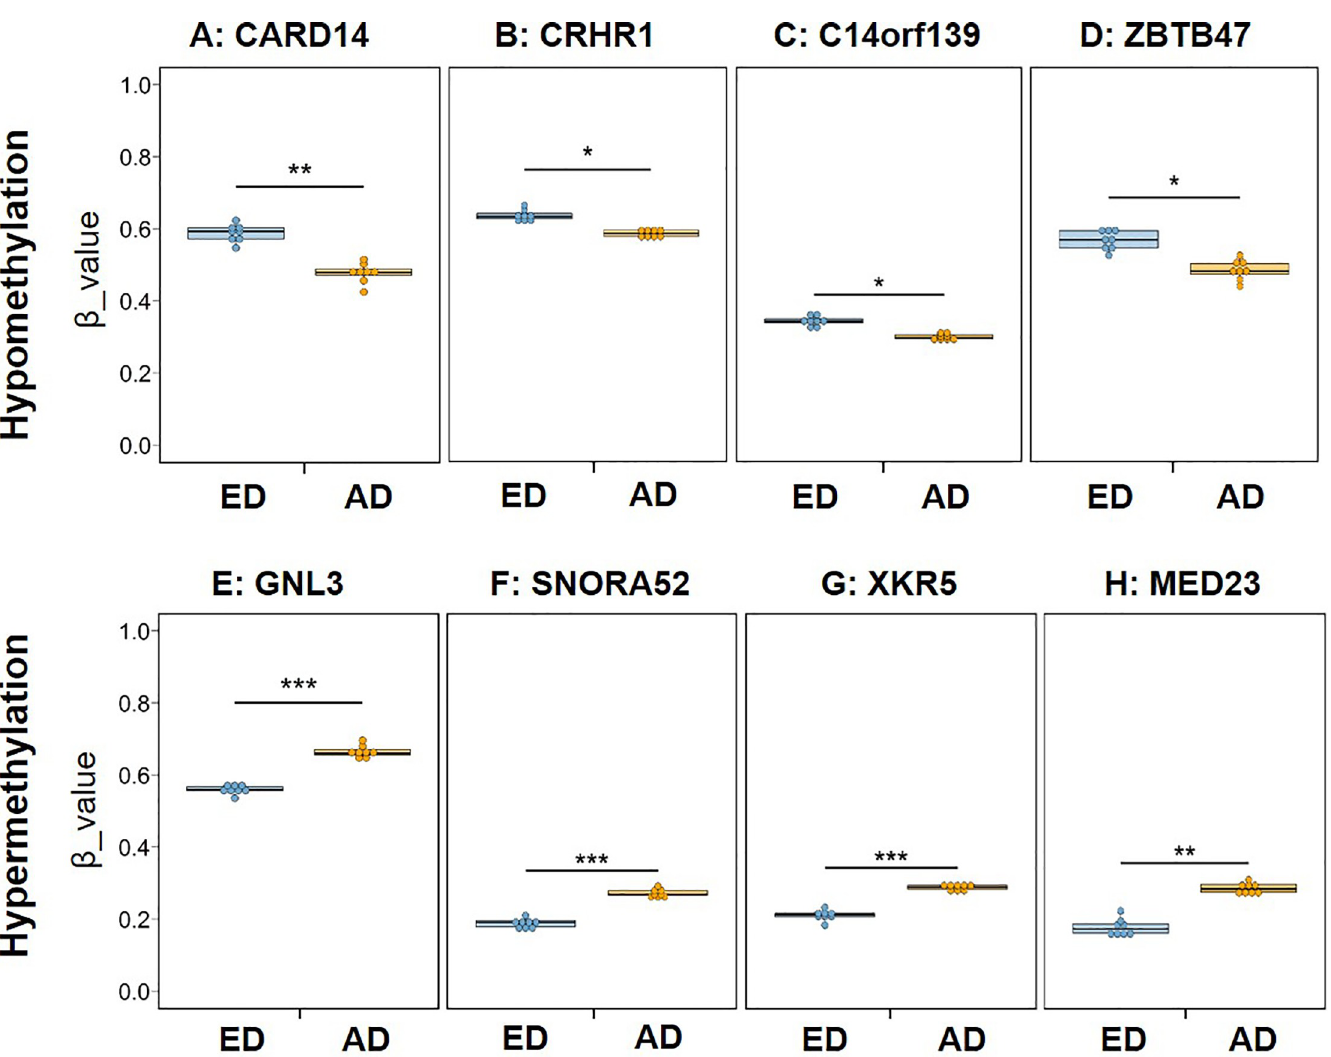
Fig 4. Differences in β value of four highest hypomethylated and hypermethylated loci between early stage (ED) and advanced stage (AD) of degeneration. � = adjust. P . Val < 0.05; �� = adjust. P . Val < 0.01; ��� = adjust. P . Val < 0.001. A: CARD14 (Caspase Recruitment Domain Family Member 14), B: CRHR1 (Corticotropin Releasing Hormone Receptor 1), C: C14orf139 (Chromosome 14 Open Reading Frame 139), D: ZBTB47 (Zinc Finger And BTB Domain Containing 47), E: GNL3 (G Protein Nucleolar 3), F: SNORA52 (Small Nucleolar RNA, H/ACA Box 52), G: XKR5 (X Kell Blood Group Precursor-Related Family, Member 5), H: MED23 (Mediator Complex Subunit 23). Human IVD samples at the early stage of disc degeneration were obtained from anterior fusion surgeries of spinal trauma patients, except for one patient. On the other hand, those at the advanced stage of disc degeneration were obtained from spinal fusion surgeries for patients with degenerative lumbar diseases, such as lumbar spinal stenosis or degenerative spondylo- listhesis. It should be kept in mind that the differences in DNA methylation profiles between these two groups, therefore, reflect not only changes in MRI findings, but also the underlying changes with/without lumbar degenerative diseases caused by progressive disc degeneration. Nevertheless, it would not be a practical issue in this study that the human IVD samples iso- lated from the patients with degenerative lumbar diseases can be regarded as the discs with advanced disc degeneration (AD).